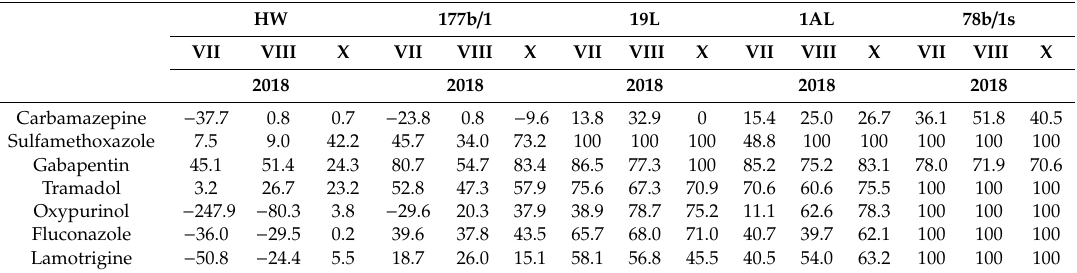
Table 5. Removal of pharmaceuticals in %. HW—Horizontal